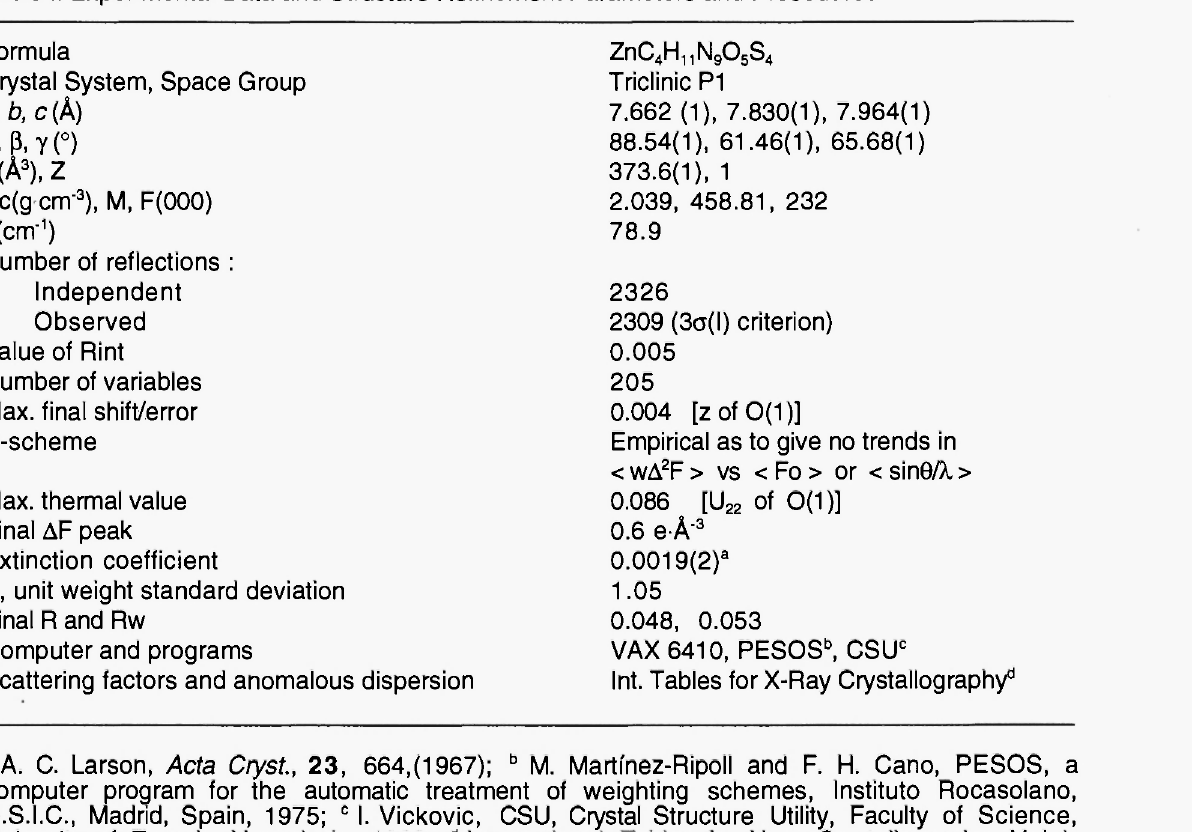
Table I. Experimental Data and Structure Refinement Parameters and Procedures